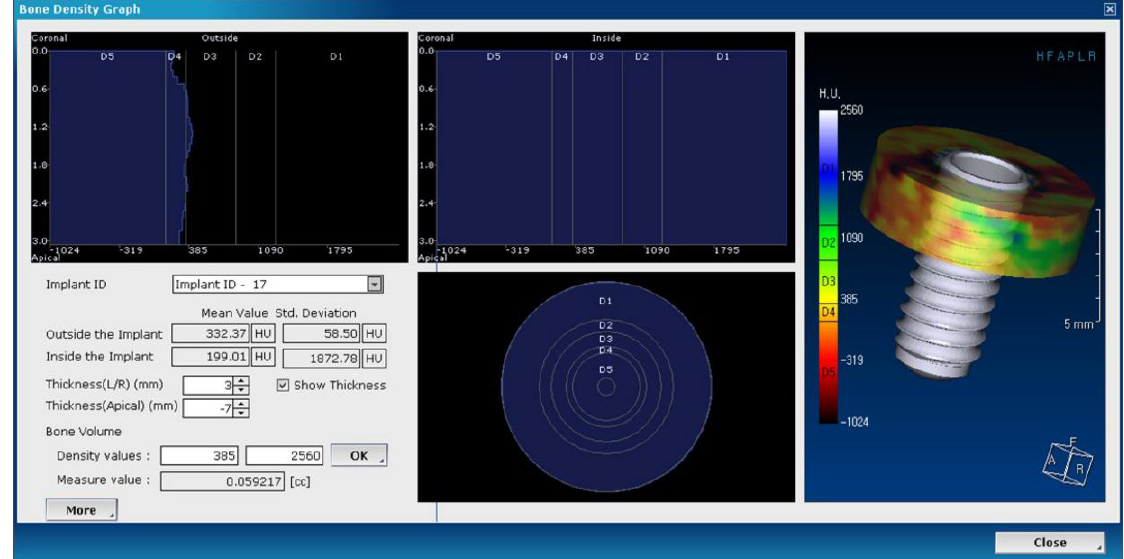
Figure 3. Bone density graph and control panel in the OnDemand3D (Cybermed) software: the values of d and dc can be controlled in the “thickness(L/R)” tab, h in the “thickness(Apical)” tab, and the range of Hounsfield Unit (HU) values in the “density value” tab.